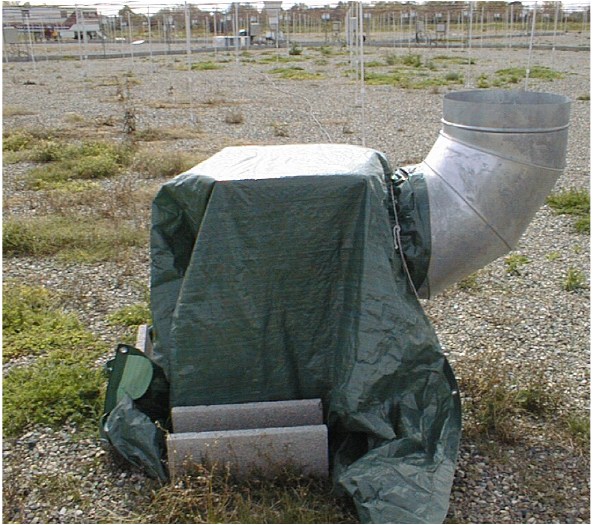
Fig. 2a. The initial acoustic source for RASS.